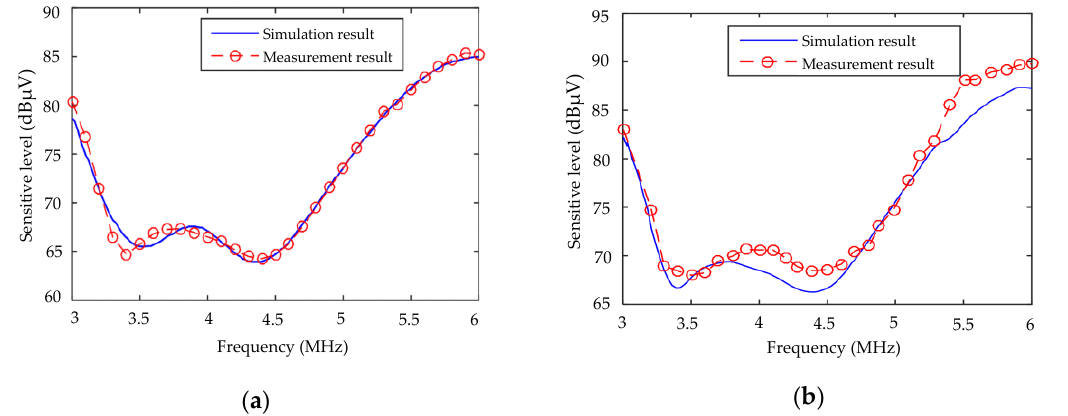
Figure 20. Sensitivity of BTM system: ( a ) Sensitivity of BTM system take the function F2: “Balise Detection Function”; ( b ) The sensitivity of BTM when the on-board antenna is at contact zone, carrying out the function F3: “Data Reception Function” and the useful signal current is I U2 = 59 mA [7].